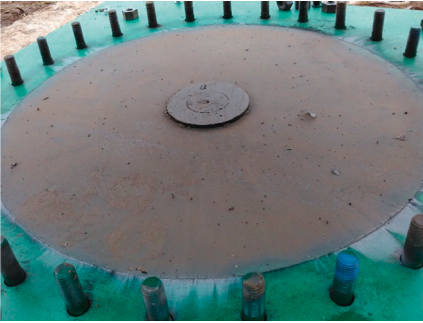
Figure 10: Residue from TNT after explosion.